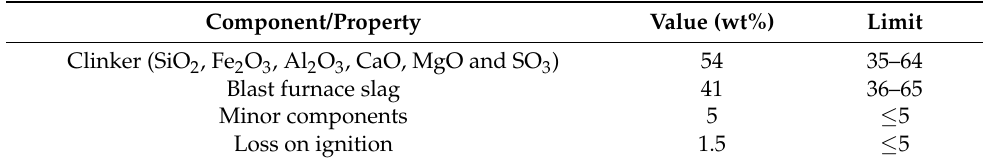
Table 4. Chemical composition of